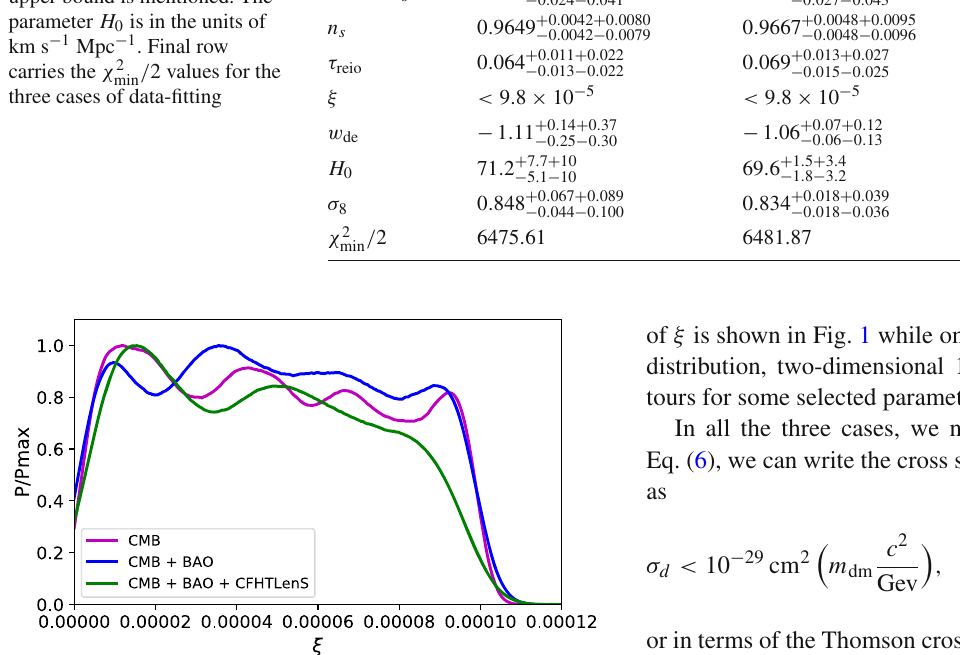
Table 1 Constraints on the free parameters and some derived parameters of the DM–DE scattering model. Mean values of the parameters are displayed with 1 σ and 2 σ CL except the parameter ξ for which the 2 σ upper bound is mentioned. The parameter H 0 is in the units of km s − 1 Mpc − 1 . Final row / 2 values for the carries the χ 2 min three cases of data-fitting